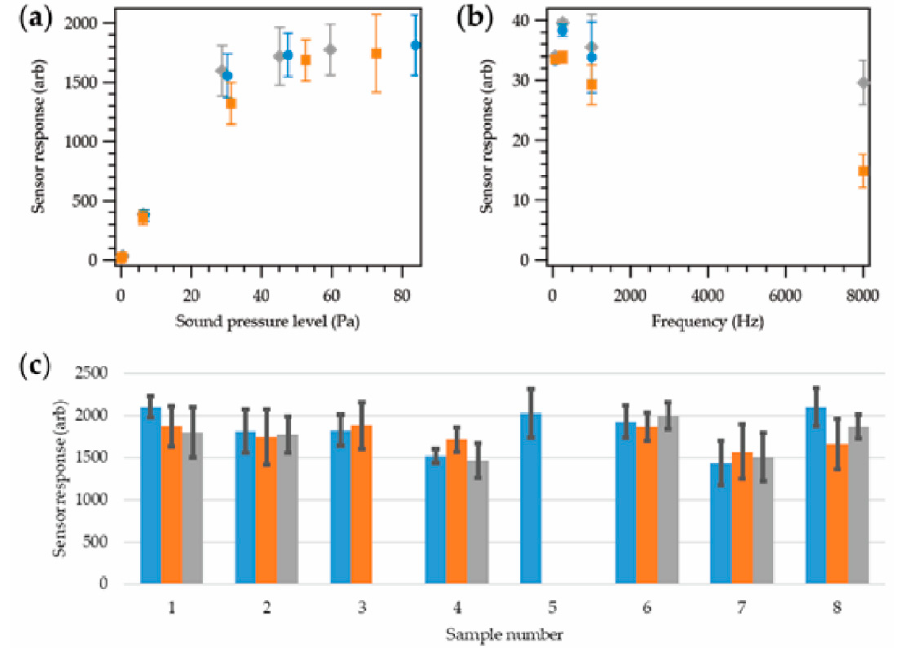
Figure 4. Sensor response for microphones at different stages of encapsulation; soldered to copper interconnects (blue; ), resin encapsulation (orange; ), final yarn (grey; ). All data points were the average of five repeat measurements. ( a ) Sensor response as a function of sound pressure level at a fixed frequency of 1000 Hz. Tests were carried out between 0.1 and 81.2 Pa (74.8–132.2 dB), with the sensor operating correctly at all amplitudes across this range. ( b ) Sensor response as a function of frequency at a fixed sound pressure level of 0.43 ± 0.02 Pa. Note that the soldered microphone was not able to detect signals at 8000 Hz correctly. ( c ) Sensor response for eight different microphones at